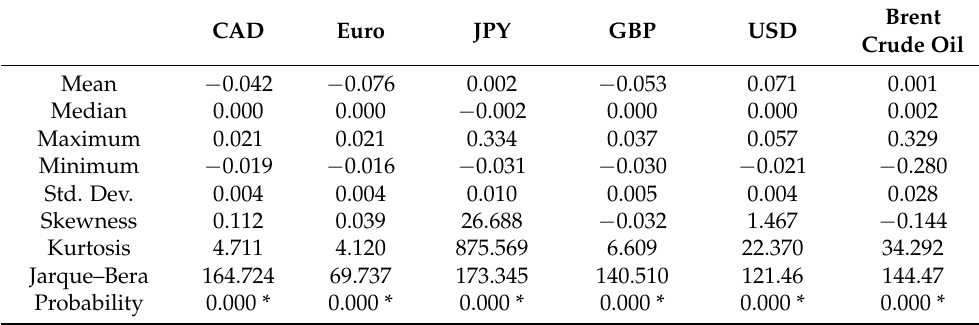
Table 2. Descriptive Statistics Results of Currency Exchange Rates and Brent Crude Oil